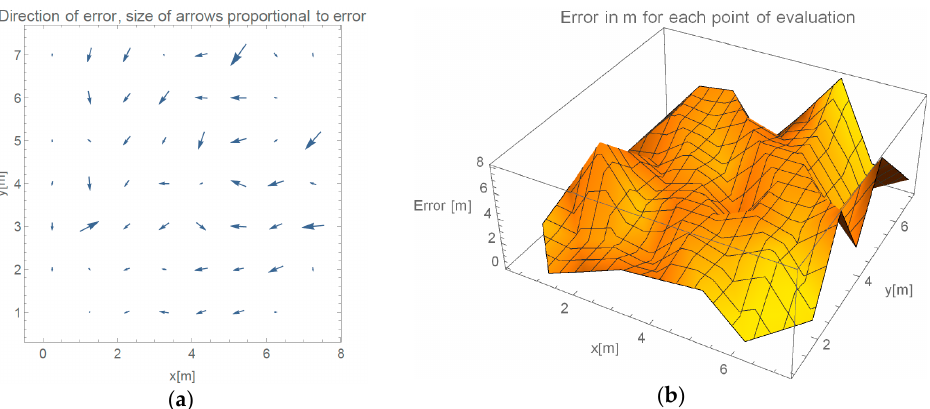
Figure 6. ( a ) Direction of errors in the case of using all available data for calculation of γ ; and ( b ) value of localization error for each reference point if all RSSIs are used for calculation.